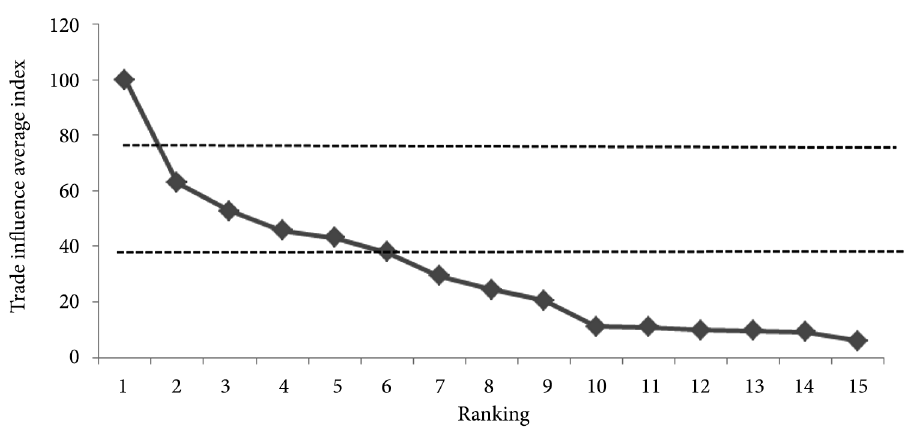
Figure 12. Mean trade influence of the top 15